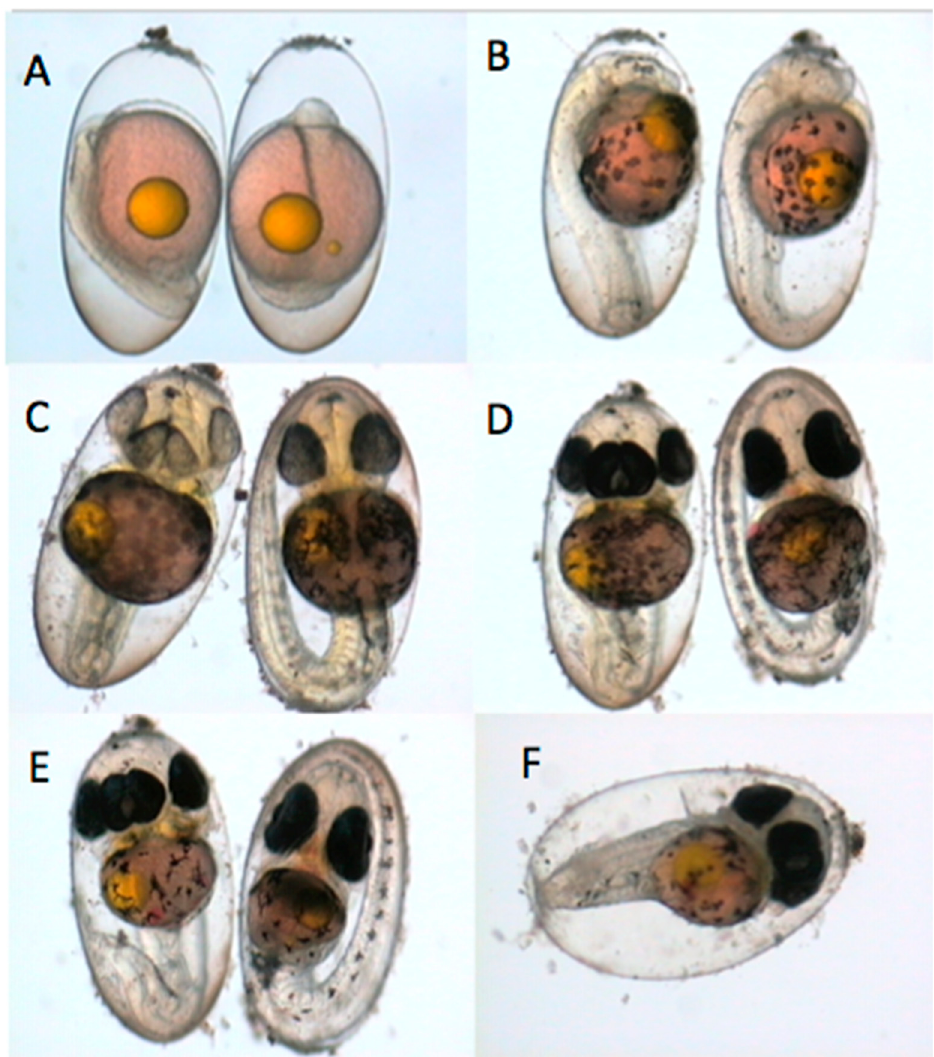
Figure 3. Daily photographs of a normal and abnormal embryo incubated in the laboratory. Both embryos are 24 h old at the beginning of the incubation. ( A ). Day 1 ( top left ): A subtle defect in the neural keel of the left embryo is observed. ( B ). Day 2: Both embryos appear to be developing normally. ( C ). Day 3: Four eyes have developed on the abnormal embryo. ( D ). Day 4: The abnormal embryo is not growing as long and appears to have edema in the heart area when compared to the normal embryo. ( E ). Day 5: The abnormal embryo is shorter and appears to have more yolk reserves remaining compared to the normal embryo. ( F ). Day 6: The normal embryo hatched and the abnormal embryo in the photo is dead. Table 2. Types and frequency of abnormal embryos that were used in the embryo incubations. Survival or the % of abnormal embryos hatching is compared to normal embryos found within the same clutch.